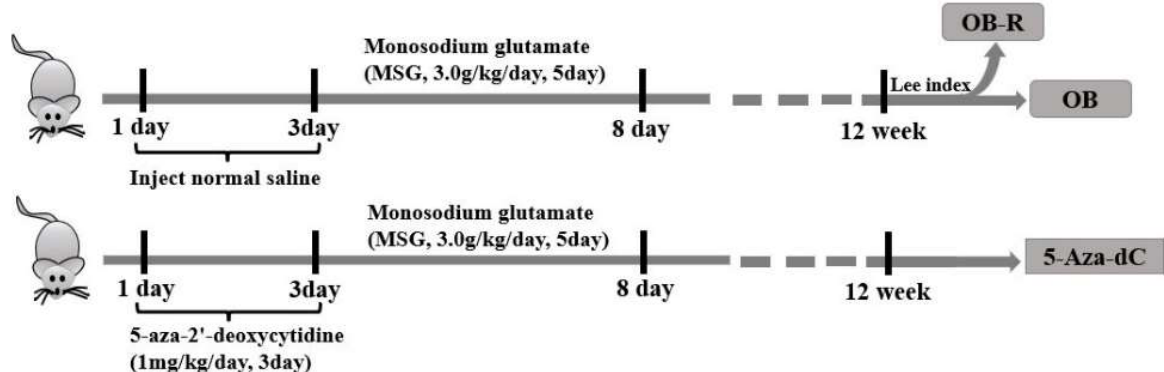
Figure 1. Graphic of the animal model design.